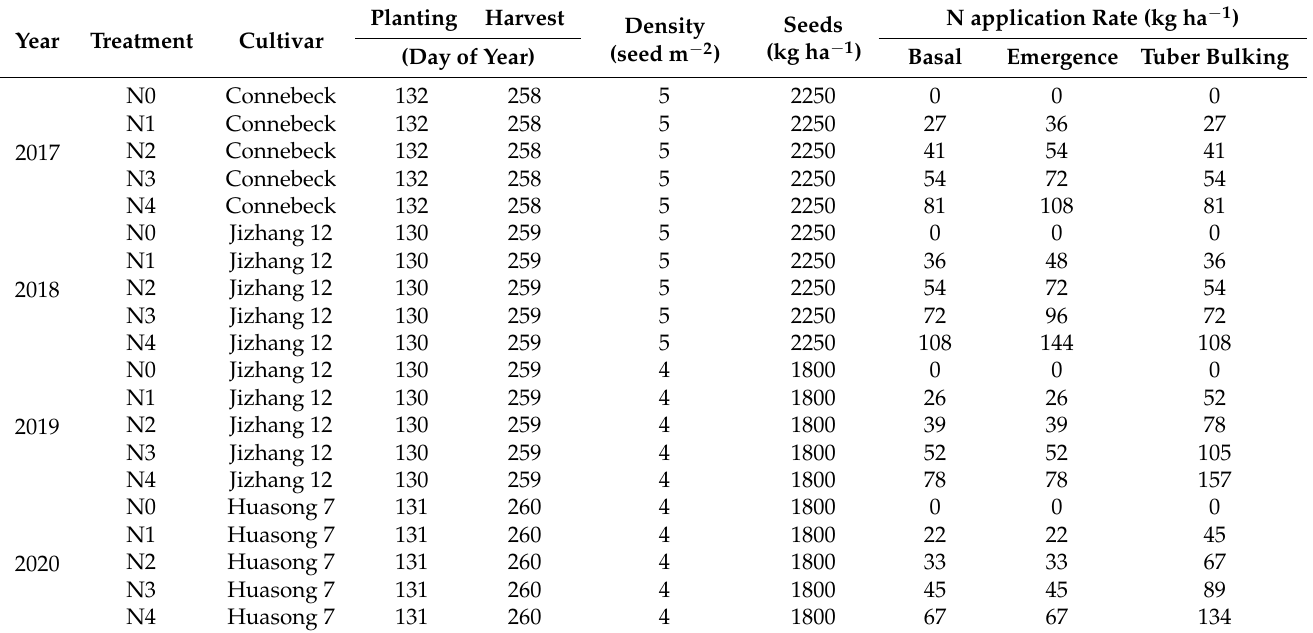
Table 1. The management practices information for potato from 2017 to 2020 at experimental